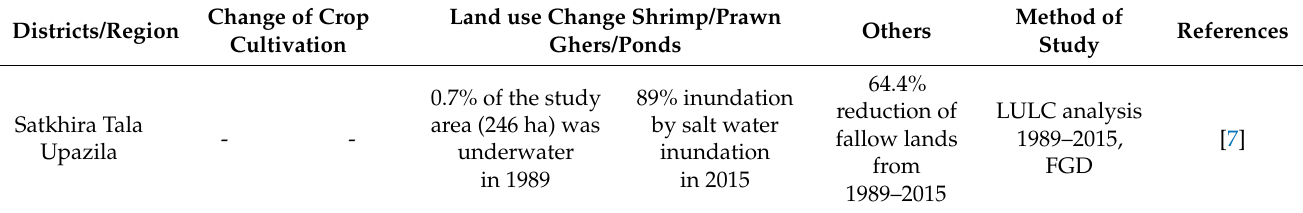
Table 1. Satellite image analysis of land conversion trends in different studies.